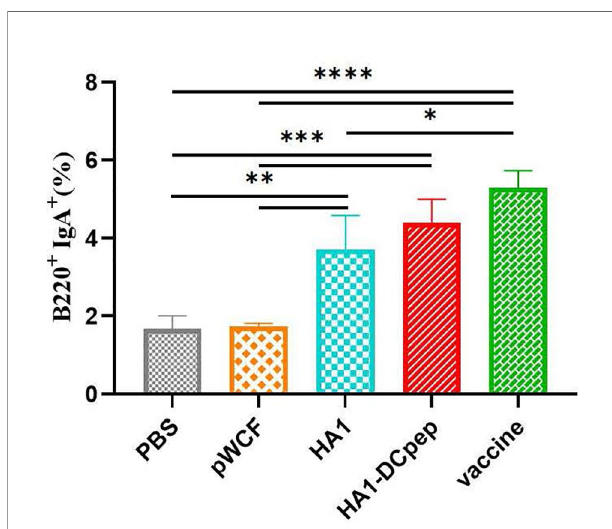
FIGURE 5 | Effect of recombinant L. plantarum on B cells. Mice PPs were harvested and used to generate cell suspensions after booster immunization; the cell suspensions were treated with anti-CD16/CD32 and staines with anti- B220 and IgA. Subsequently, the cells were evaluated by fl ow cytometry. Statistical signi fi cance was assessed by one-way ANOVA (n = 3 mice per group). *P < 0.05; **P < 0.01; ***P < 0.001; ****P <